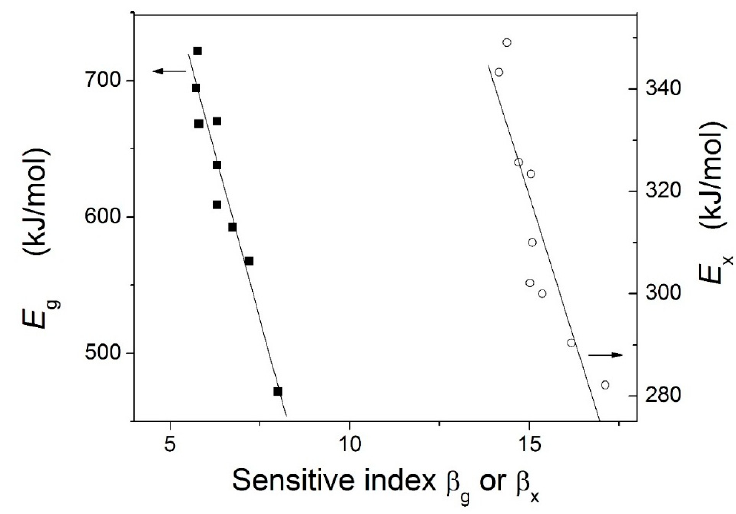
Figure 10. Relationships between the sensitive index and the activation energy.